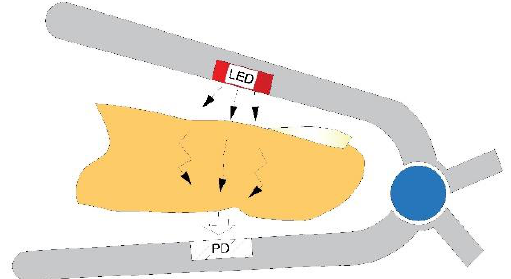
Figure 1. Conventional transmission PPG device setup.